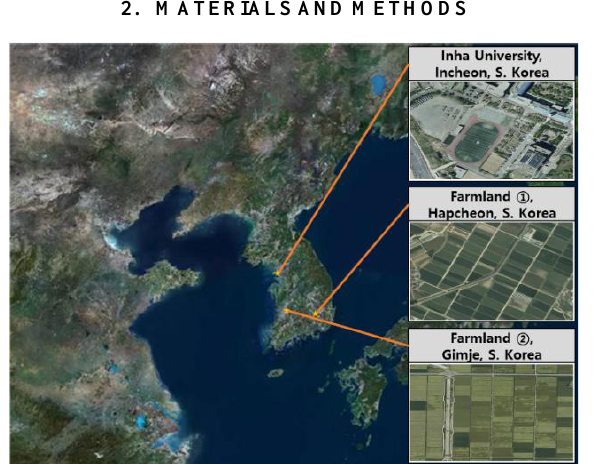
Figure 2. Locations of target areas on South Korea map